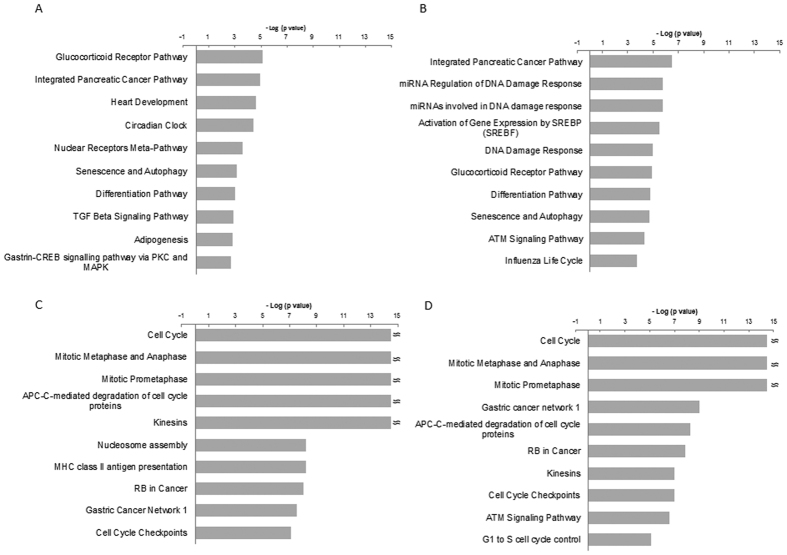
Top 10 pathways enriched for pathway analysis through WikiPathways in upregulated genes.The results from the pathway analysis through WikiPathways are depicted within the category of upregulated genes. (A) LUV, at 4 h (B) HUV, at 4 h (C) LUV, at 12 h (D) HUV, at 12 h. The Y-axis shows the minus logarithmic value of each p-value indicating the validity of each pathway. The accession number of each pathway for WikiPathways was saved; refer to the raw data in Supplementary Tables S1–4.